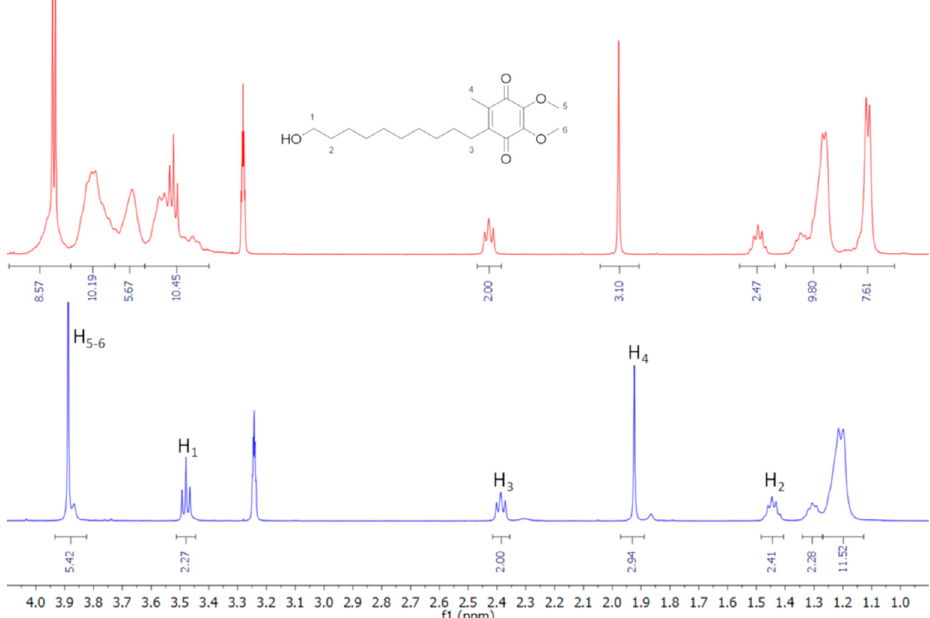
Figure 12. Stacked portions of 1 H-NMR spectra relative to free IDE (bottom) and IDE/HP- β -CD complex (top). 1 H-NMR chemical shift assignments for free idebenone (IDE) and